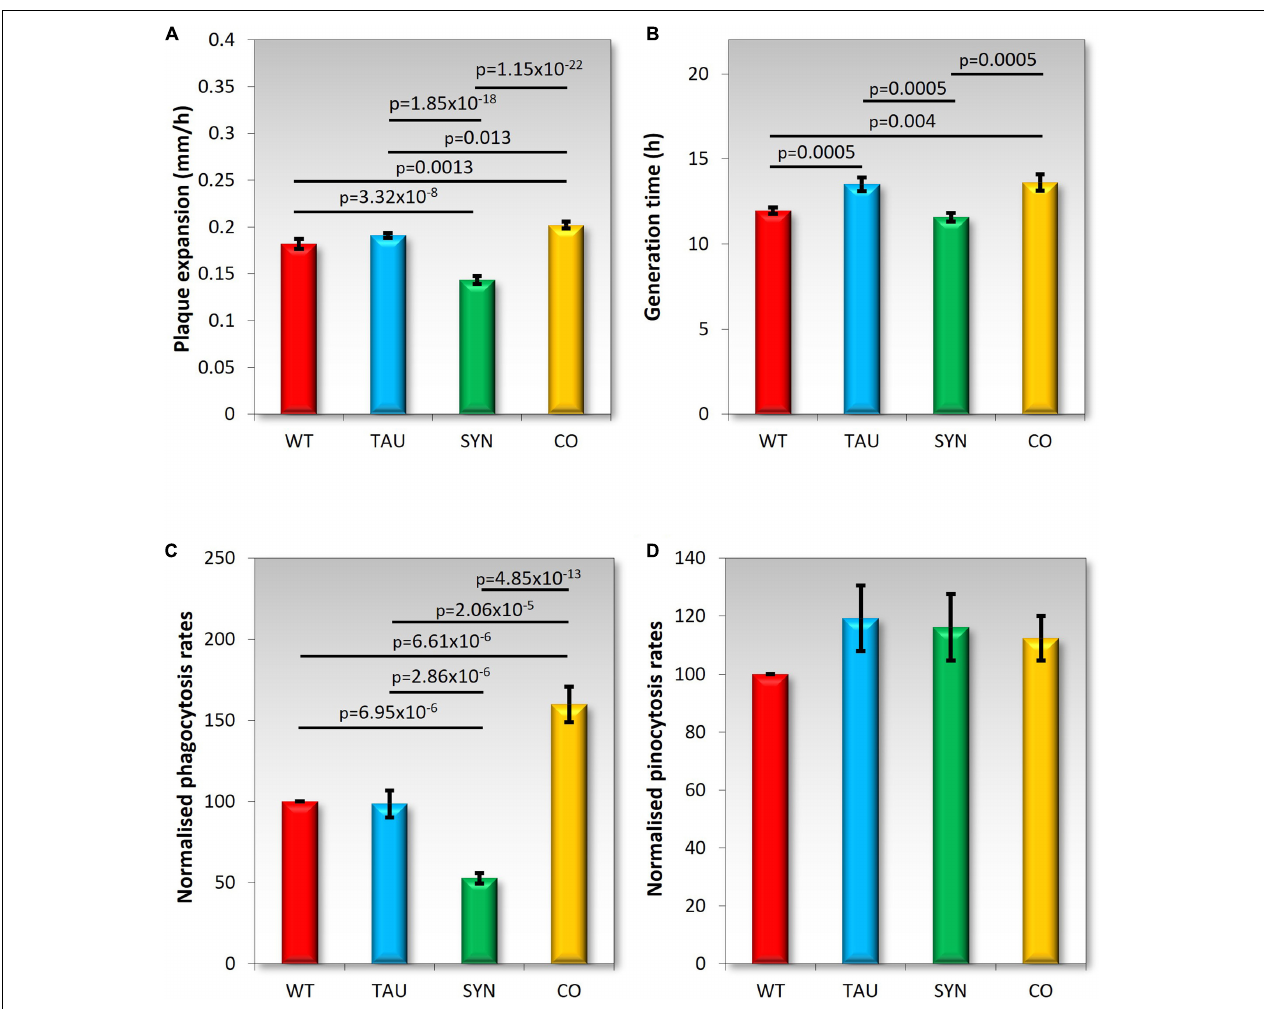
FIGURE 4 | Growth and endocytosis Wild type AX2 (WT) and strains expressing tau (TAU), α -synuclein (SYN), or both tau and α -synuclein (CO) were tested. (A) Plaque expansion rates were measured during growth on bacterial lawns of E. coli B2. Plaques were measured twice daily over one hundred hours. Experiments were performed in triplicate in four different experiments. As previously seen (Fernando et al., 2020) α -synuclein-expressing strains display slower growth on bacterial lawns when compared to the WT AX2. Tau does not affect growth on plates, but strains expressing both tau and α -synuclein grew slightly but significantly faster. (B) Axenic growth rates were measured by determining the generation time of strains (doubling in exponential growth phase). Strains were grown in HL5 liquid medium on a shaker at 21 ◦ C for 100 h. Experiments were performed on tau and cotransformant strains over four separate experiments. As previously shown, α -synuclein did not affect axenic growth (Fernando et al., 2020). Strains expressing tau displayed significantly longer generation times during growth in liquid medium. Strains expressing both tau and α -synuclein also showed significantly longer generation times than AX2. Error bars are standard errors of the mean, p-values represent statistically significant values using a two sample t -test. (C) Phagocytosis rates were measured by feeding D. discoideum amoeba E. coli DS-Red and taking fluorescent measurements directly after addition of the bacteria, then again after 30 min of incubation at 21 ◦ C on a shaker. The uptake rates of bacteria were normalised to the rate of uptake of AX2 (WT). Tau did not affect phagocytosis rates and shows a similar uptake rate to AX2. Previously, α -synuclein expression caused a significant decrease in phagocytosis rates (two-sample t -test pictured). The coexpression of tau and α -synuclein significantly increased the rate of phagocytosis (two-sample t -test). Cell lines were assayed in at least three separate experiments (D) Pinocytosis rates were measured by feeding D. discoideum amoeba with HL5 that contained FITC-dextran. Fluorescent measurements were taken directly after the addition of the FITC-dextran and again after an incubation period of 70 min at 21 ◦ C on a shaker. Cell lines were assayed in at least three separate experiments. Pinocytosis rates were not significantly affected by the expression of tau, α -synuclein (Fernando et al., 2020), or the combined expression of these two